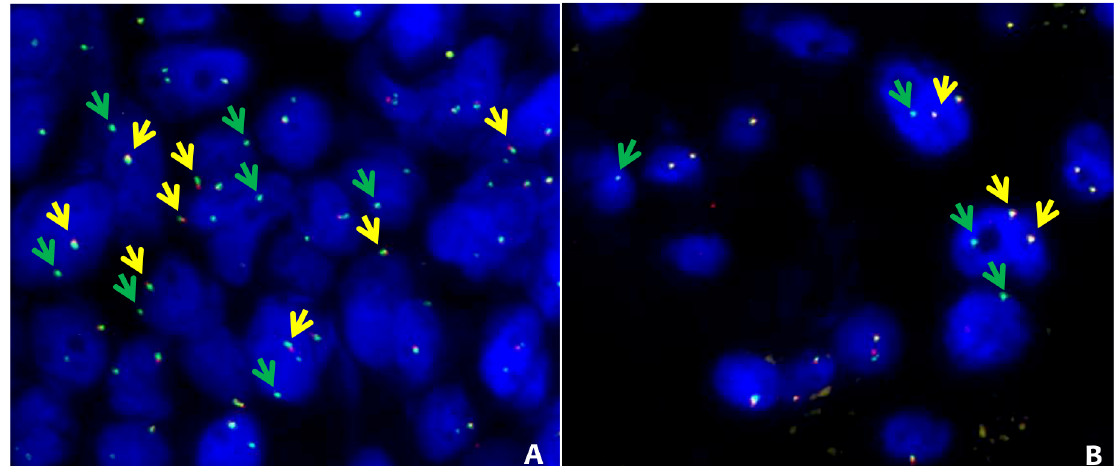
Figure 4. ROS1 and RET alternative FISH pattern. FISH results obtained in 2 patients with ROS1 (sample 61, Table S3 ) and RET (sample 63, Table S3 ) with alternative FISH patterns. A: ROS1 break-apart fusion. The intact ROS1 alleles are indicated by the yellow arrows (green plus red), while green arrows indicate isolated green signals corresponding to 3’ ROS1 derivative. B: RET break-apart fusion. Intact RET alleles are indicated by the yellow arrows (green plus red), while green arrows indicate isolated 3’ RET derivatives. FISH break-apart probes SPEC ROS1 Dual Color Break Apart Probe Zyto Light (cat: Z-2144-50) and SPEC RET Dual Color Break Apart Probe Zyto Light (cat: Z-2148-200) were purchased from Zytovision (Williamsville, New York, USA) and were hybridized according